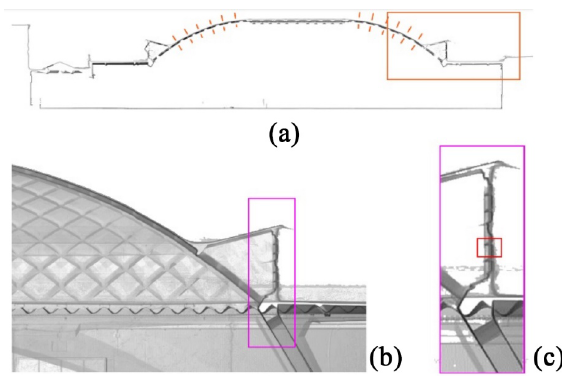
Figure 8 . Longitudinal section of the integrated 3D model (LiDAR+UAV) (a), with a zoomed view (b) of the vaulted system node and the perimeter skylights (b).